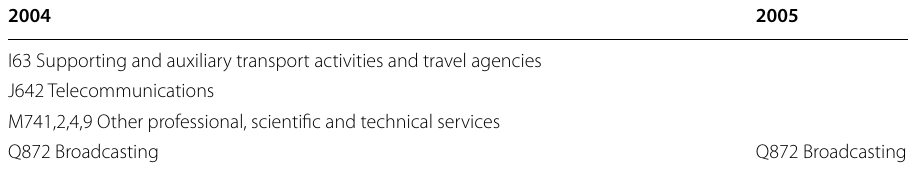
Table 12 Industries whose dispersion power indices are in the third quadrant